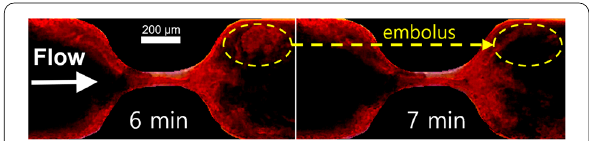
Fig. 6 Process by which part of the thrombus was separated from the thrombus body in a channel where the stenosis is 83.73%